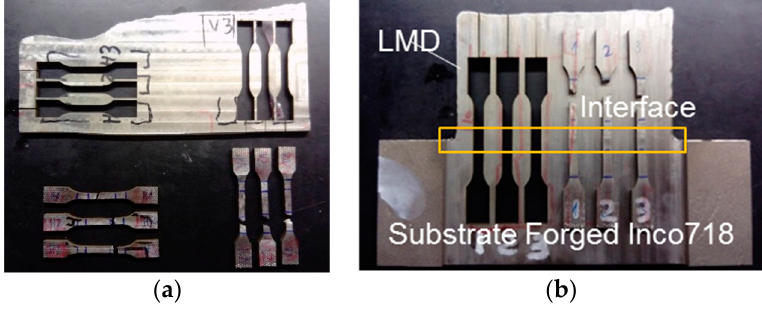
Figure 5. Specimens for tensile tests extracted from laser metal deposition (LMD) walls: ( a ) specimens in horizontal and vertical direction for evaluating the added material; ( b ) specimen for evaluating the union between the wall and the substrate material.